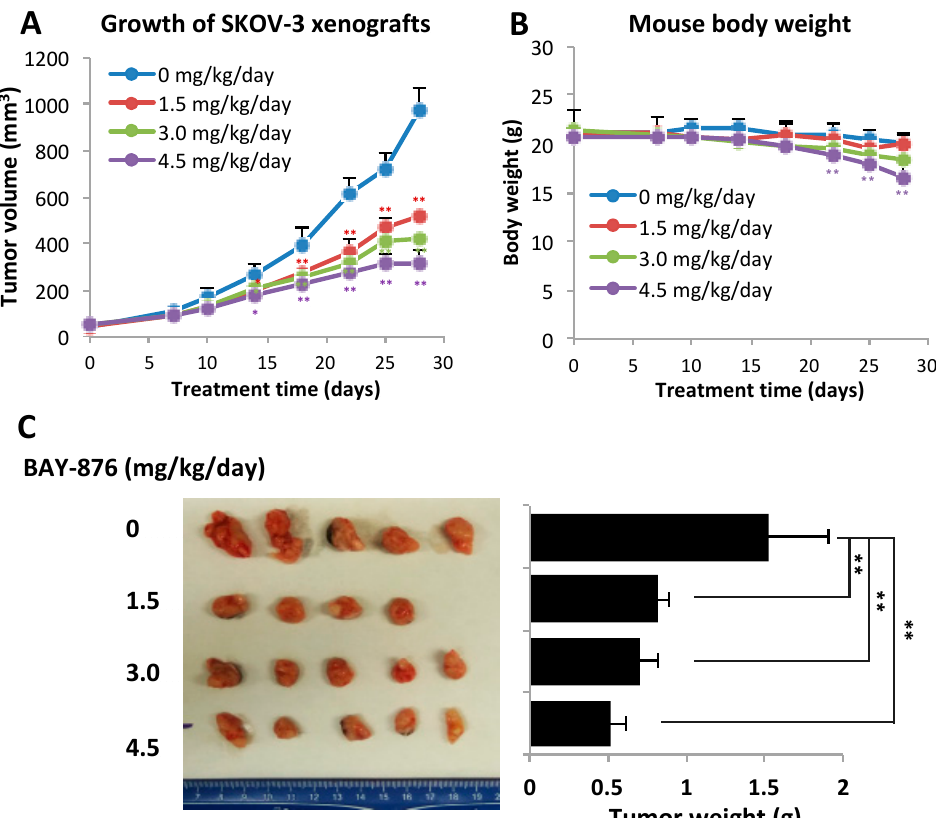
Figure 5. BAY-876 inhibits growth of SKOV-3 xenografts in mice. Four groups of female NSG mice bearing SKOV-3 xenografts were treated with BAY-876 for 28 days at dose of 0, 1.5, 3, or 4.5 mg/kg/day. Data shown were growth curves of tumor volumes ( A ), body weights over the course of experiment ( B ), images of end point tumors and final tumor weights ( C ). The data of all animal experiments were presented as mean ± SD. ** p < 0.01.